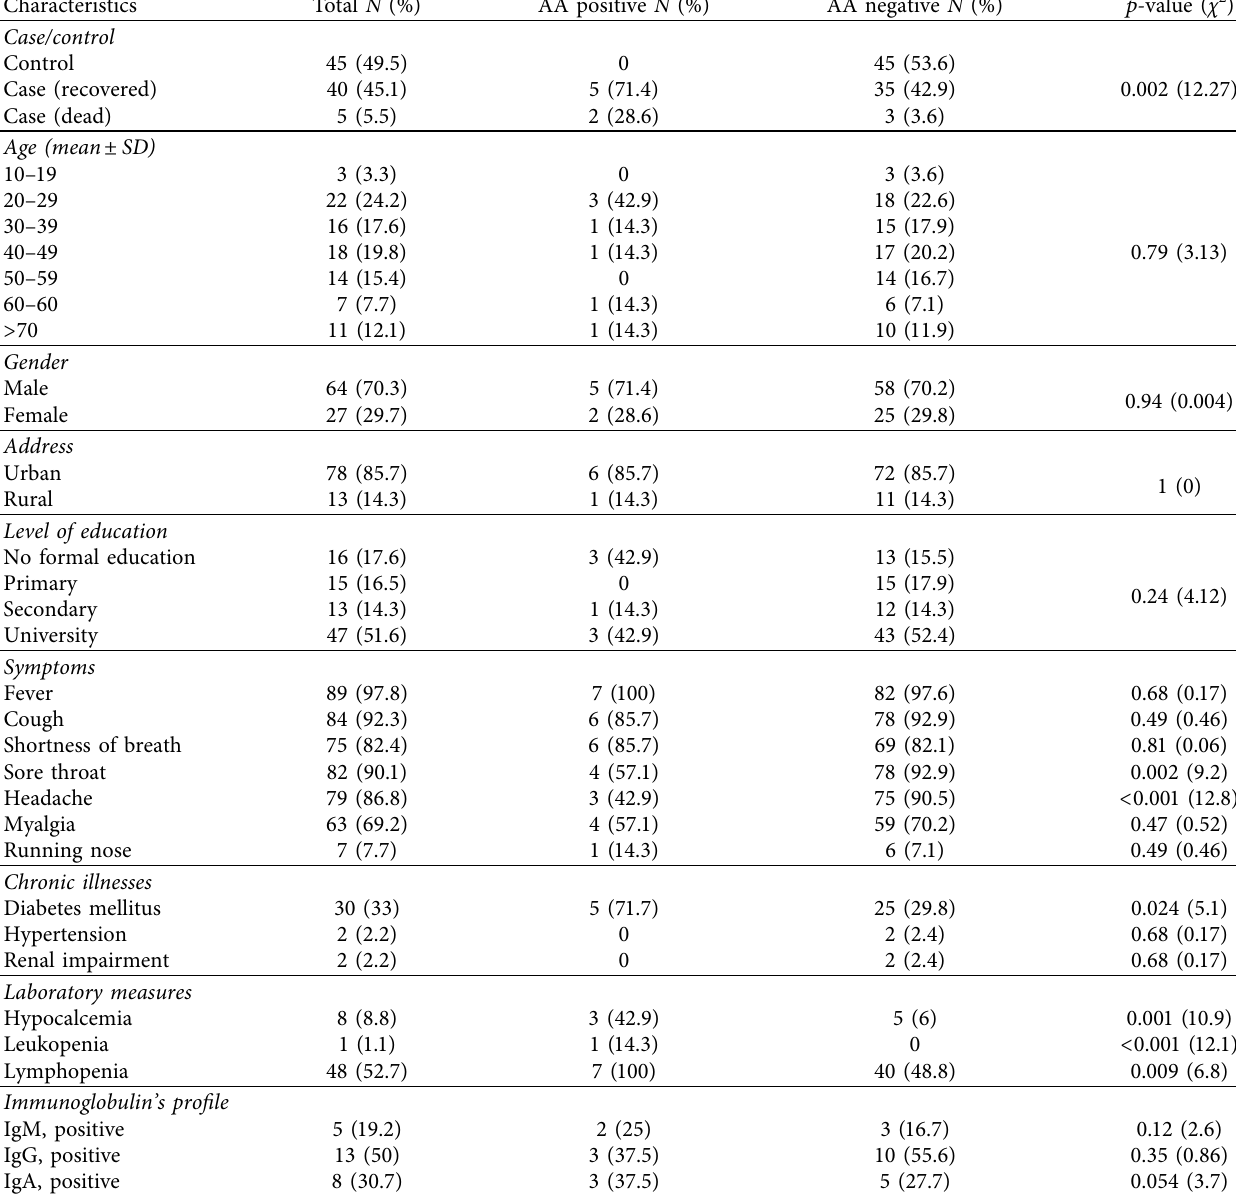
Table 3: Autoantibodies profle of study